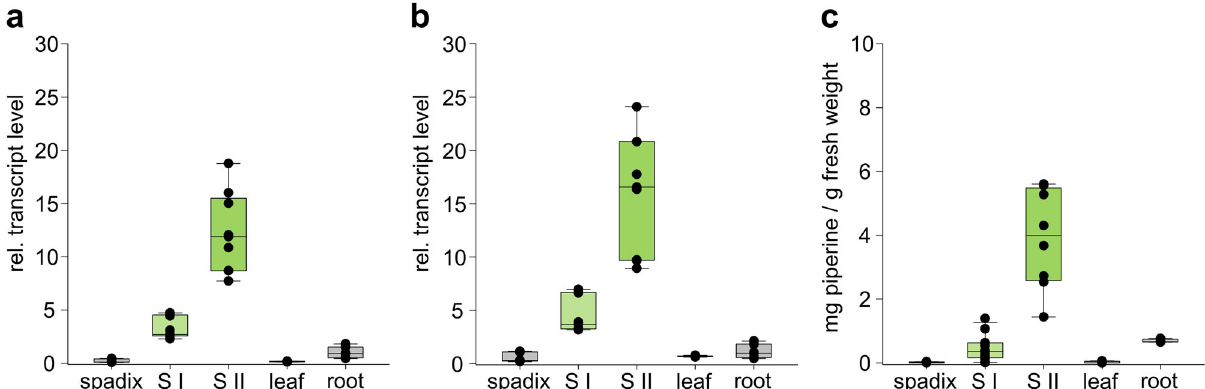
Fig. 3 Organ-speci fi c relative transcript levels of two black pepper BAHD-type transferases based on RT-qPCR. a PipBAHD1 (piperamide synthase). b PipBAHD2 (piperine synthase). Each box represents nine data points consisting of three biological replicates with three technical replicates each. Transcript levels and also piperine levels of fl owering spadices; S I (fruits, stage I, 20 – 30 days post anthesis); S II (fruits, stage II, 40 – 60 days post anthesis), young leaves; 5, roots are shown. Elongation factor (elF2B) was used as a reference 15 . c Level of piperine in spadices, fruits (stages I and II, 20 – 30 and 40 – 60 days post anthesis, respectively), leaves, and roots of black pepper. Piperine levels rise further until ~100 days post anthesis (see also Fig. 1).